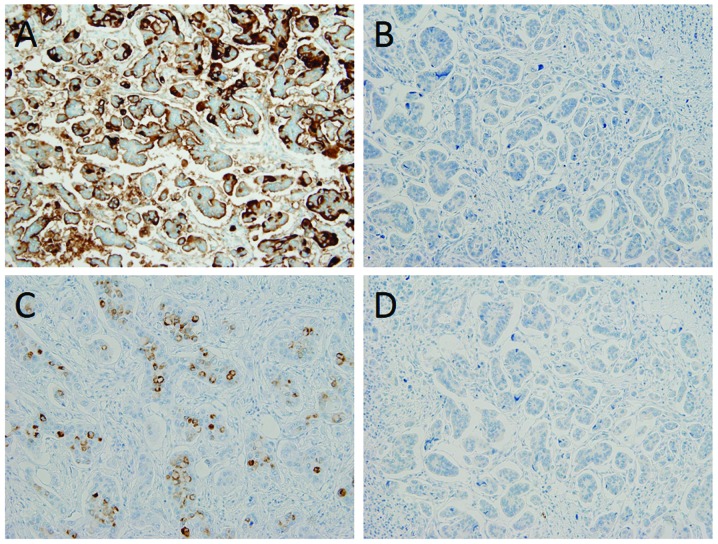
Immunohistochemical findings of a representative case. The ‘inside-out’ structures of IMPC were positive for MUC1 at peripheral cell membranes (A, top left), negative for MUC2 (B, top right), focally positive for MUC5AC (C, bottom left) and negative for MUC6 (D, bottom right). IMPC, invasive micropapillary carcinoma.